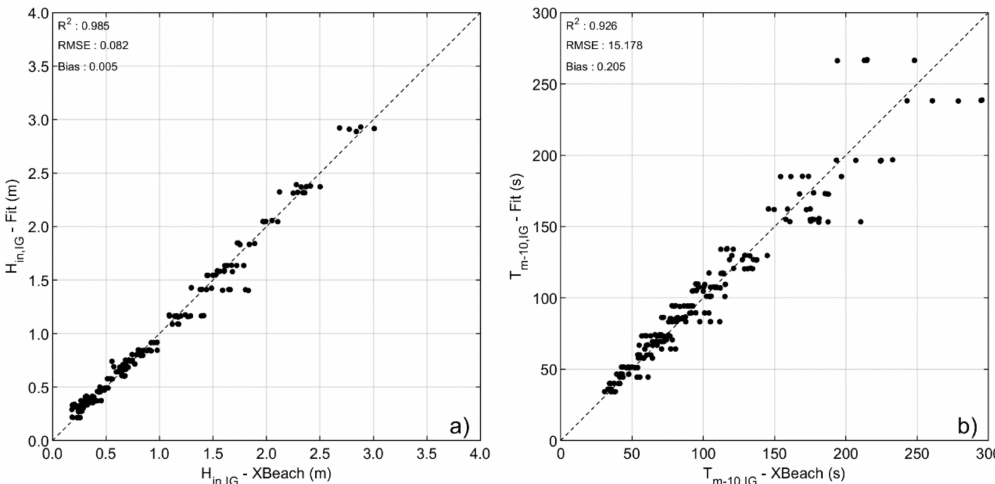
Figure 8. Comparison of XBeach-NH+ and empirical fit for incoming infragravity wave height ( a ) and period T m -01, in , IG ( b ) near the shoreline. Dashed line indicates unity (y =